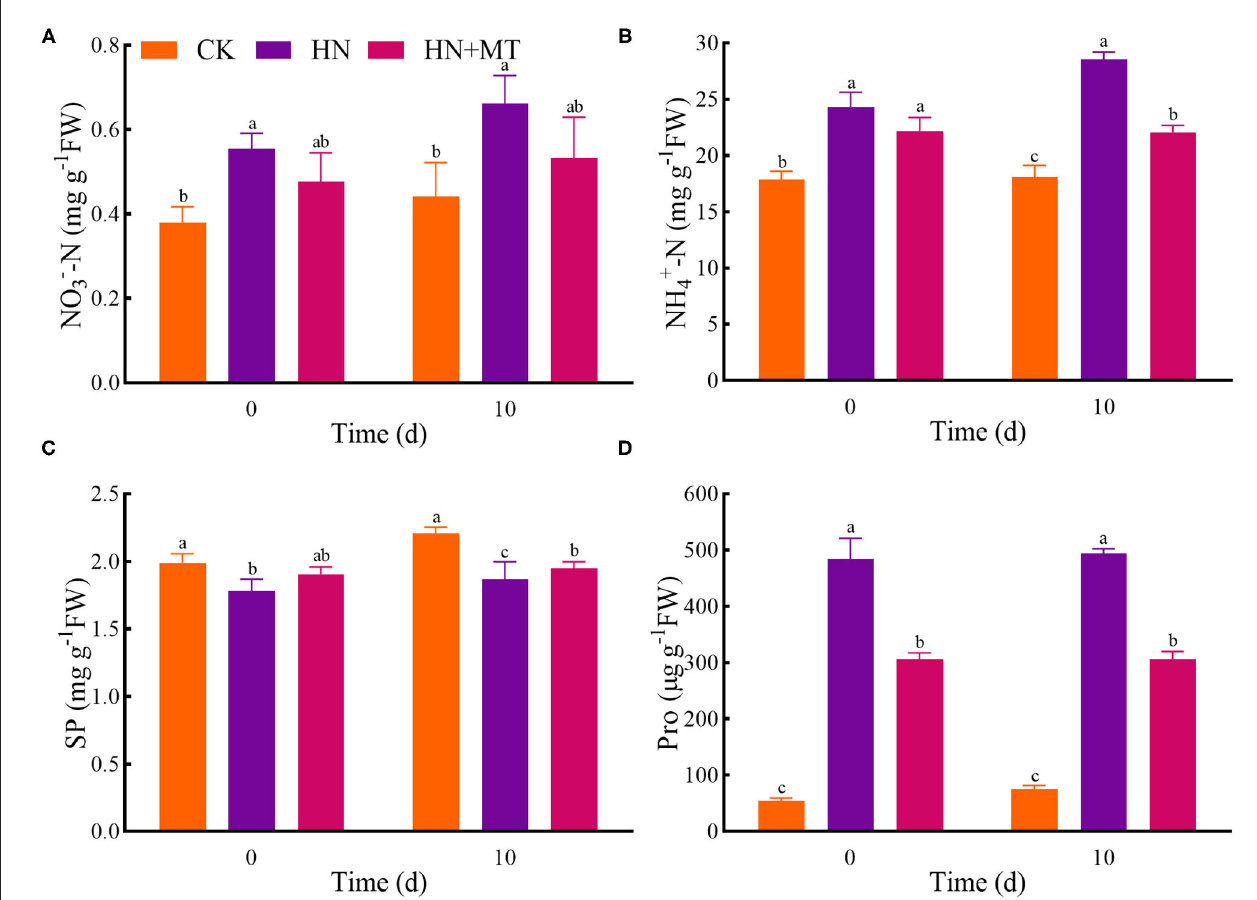
FIGURE 3 | Changes of NO − 3 -N (A) , NH + 4 -N (B) , SP (C) , and Pro (D) . The groups on the same day followed with the same letter are not significantly different at p < 0.05. Bars indicate the SDs of the